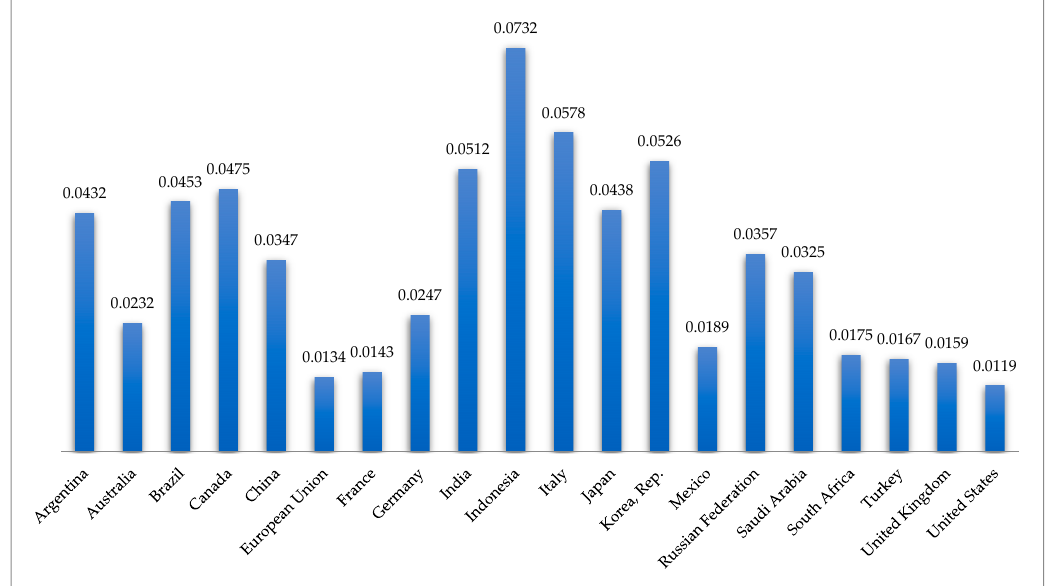
Energies 2018 , 11 , x 12 of 15 To evaluate the proposed model and examine the competency of the prediction models of ANFIS, the MAE measure was applied to the prediction of the outputs, i.e., CO 2 emissions. The MAE measures the average magnitude of the errors in a set of predicts, without considering their direction. It measures the accuracy for continuous variables. The MAE is the average over the verification sample of the absolute values of the differences between the forecast and corresponding observation. The MAE is a linear score, which means that all the individual differences are weighted equally in the average. Accordingly, errors of the prediction models were computed using MAE, as shown in Equation (6). In addition, the results of MAE for all countries are presented in Figure 5. Figure 4. CO 2 Prediction based on Economic growth and energy consumption for the United States.